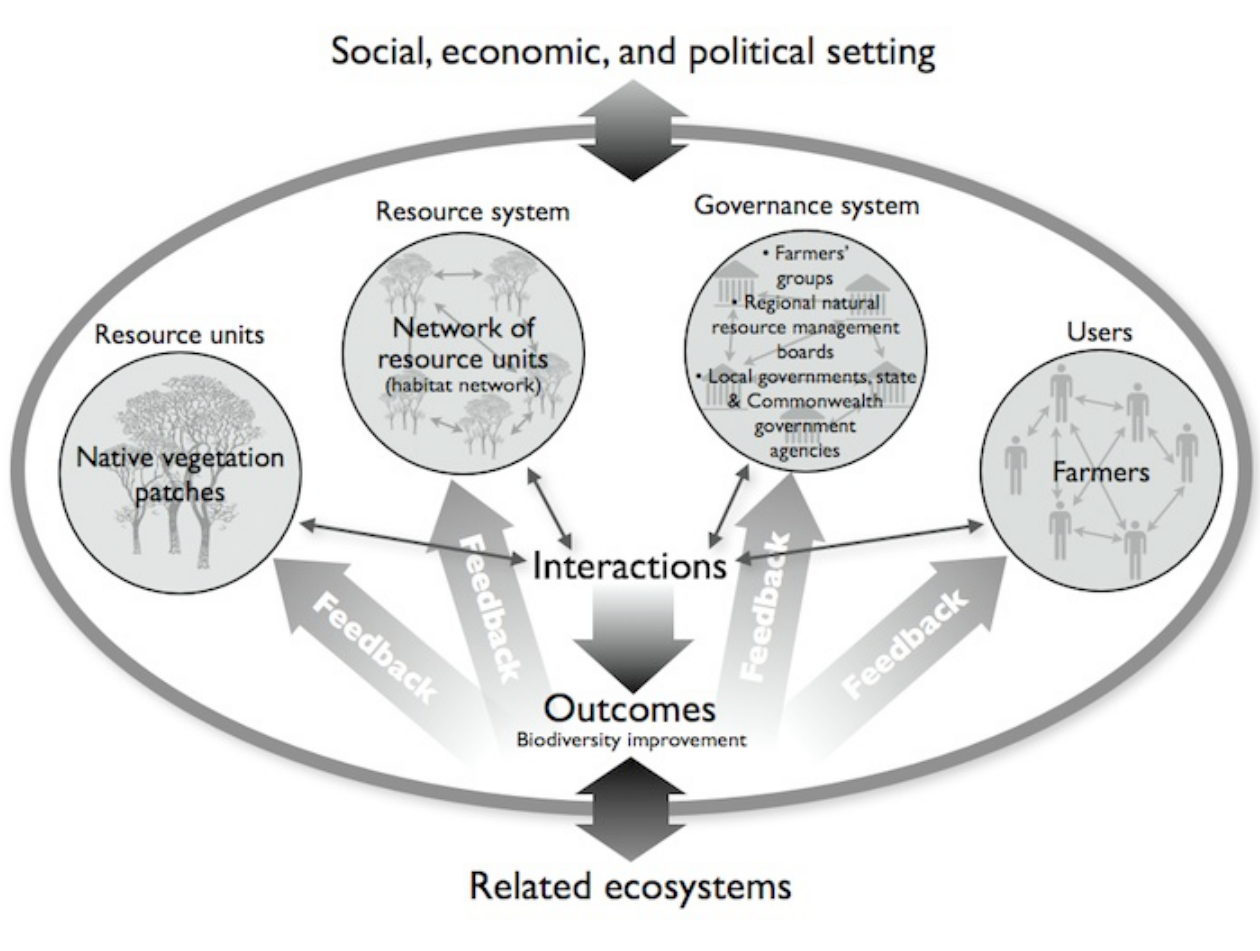
Fig. 6 . Conceptual diagram of the social-ecological system of the Eyre Peninsula, South Australia, based on Ostrom’s framework (Ostrom